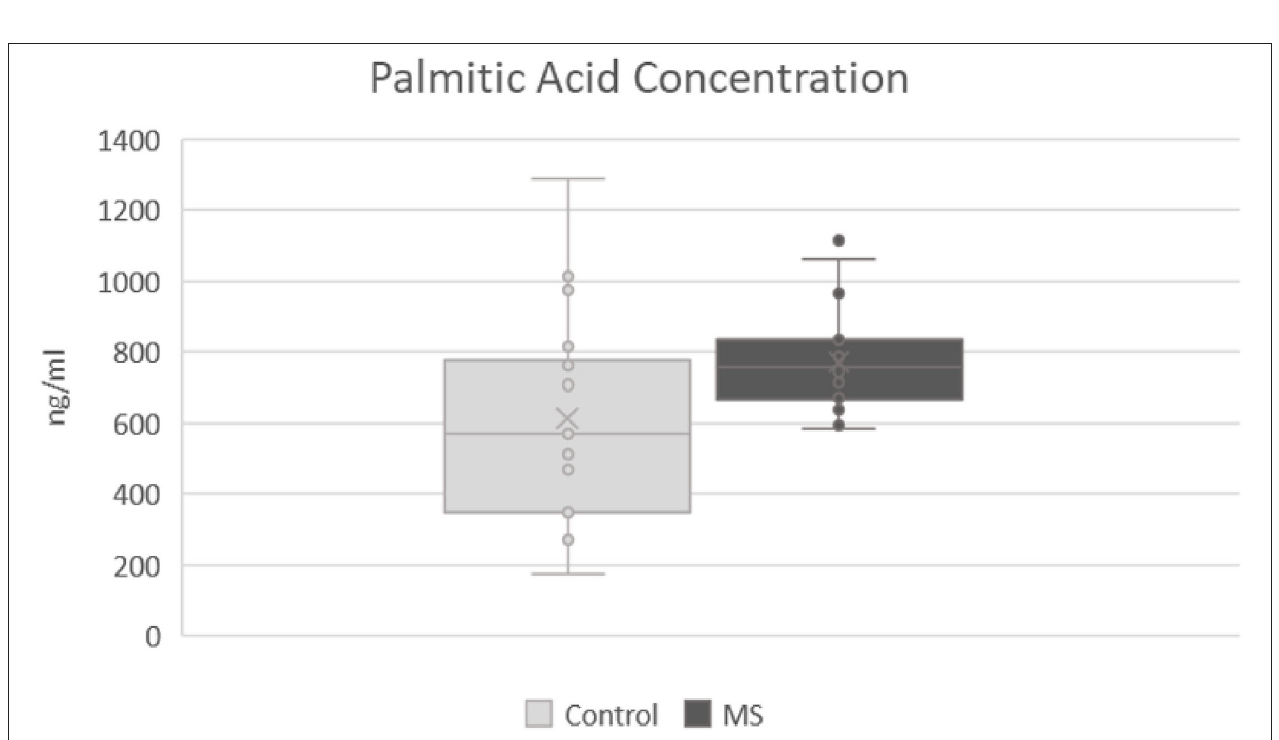
FIGURE 3 | Comparison of levels of palmitic acid in patients after first attack of clinical symptoms fulfilling revised McDonald criteria and control group. MS, patients after first attack of clinical symptoms fulfilling revised McDonald criteria; control, control group.